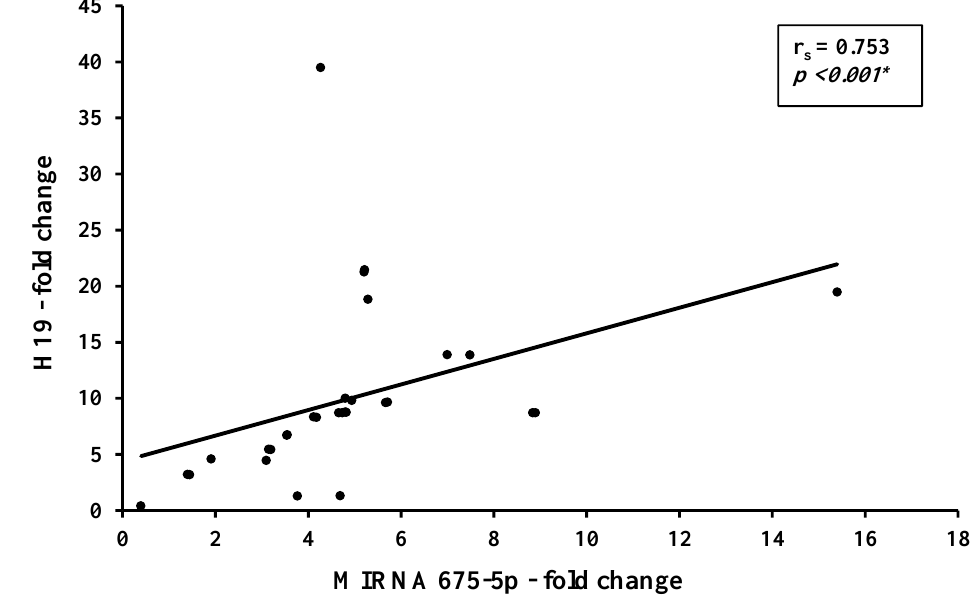
Figure 8. Correlation between circulating H19 with miR-675-5p in presurgery BC patients ( n = 30). * Statistically significant at p ≤ 0.0 01